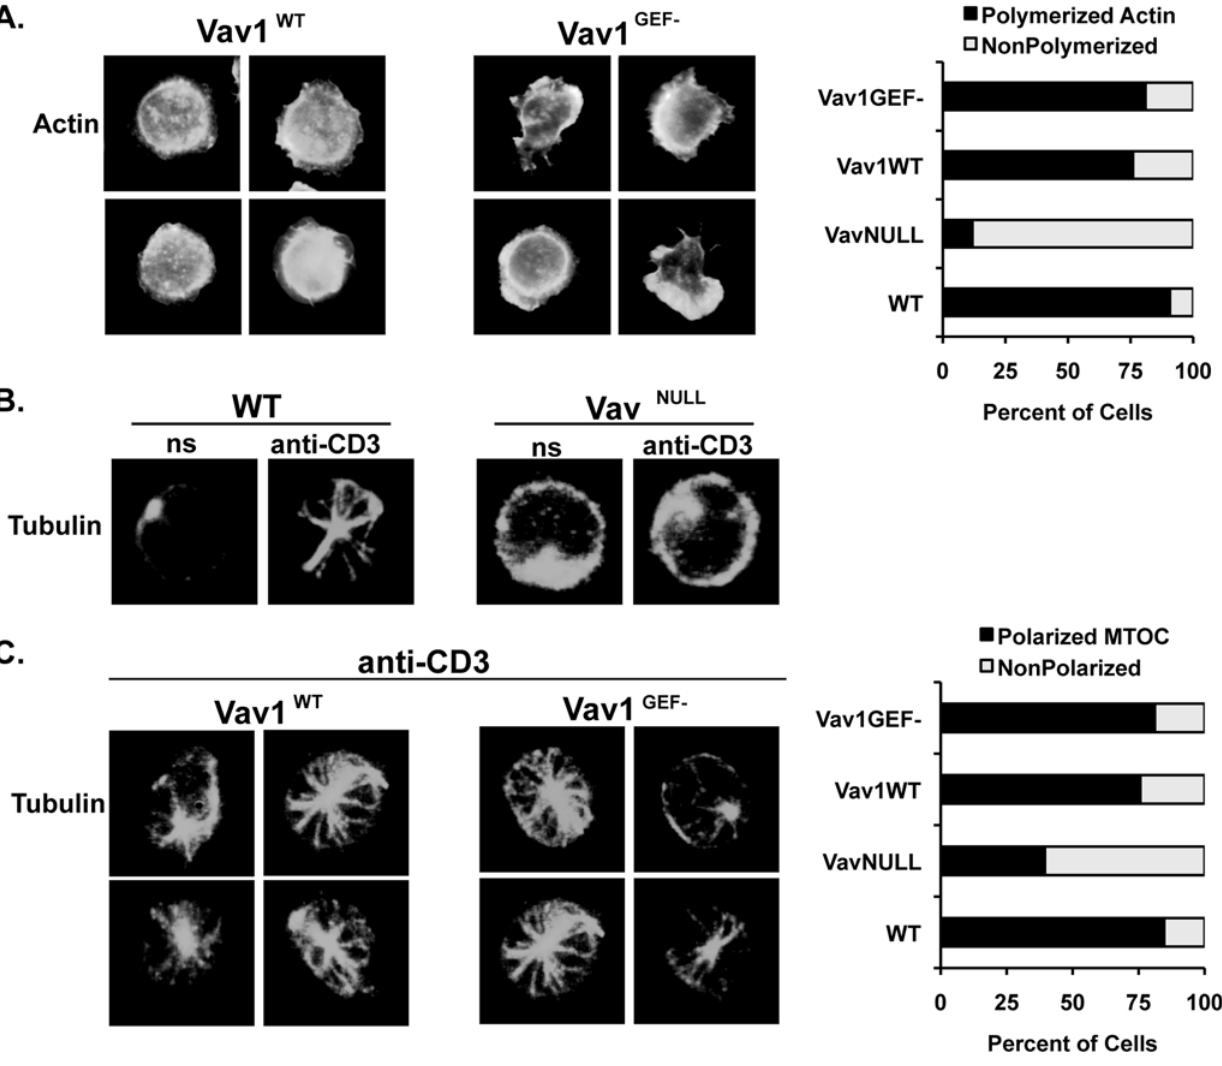
Figure 7. Expression of Vav1 GEF 2 restores TCR-induced actin polymerization and MTOC polarization in Vav NULL T cells. (A) Left panels: Actin polymerization of purified Vav1 WT and Vav1 GEF 2 T cells incubated on anti-CD3 antibody-coated coverslips as described in Figure 1. Right panel: Graphical display of the percentages of the indicated T cells that exhibited actin polymerization after stimulation, n . 400 cells per group. (B) Purified T cells from WT and Vav NULL mice were either incubated on PBS-coated coverslips (ns=nonstimulated) or were incubated on anti-CD3 antibody-coated coverslips for 30 minutes and MTOCs visualized by staining with fluorescein (FITC)-anti- a -tubulin. (C) Left panels: Purified T cells from Vav1 WT and Vav1 GEF 2 mice were incubated on anti-CD3 antibody-coated coverslips for 30 minutes and MTOCs visualized as described in (B). Right panel: Graphical display of the percentages of the indicated T cells that exhibited MTOC polarization after stimulation, n . 152 cells per group. doi:10.1371/journal.pone.0006599.g007 PLoS ONE |